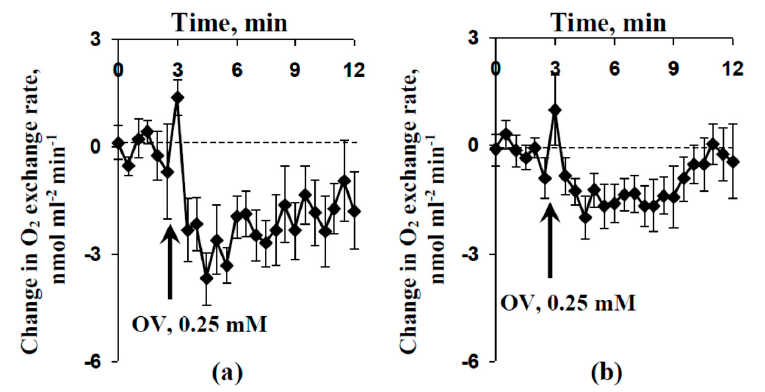
Figure 8. Average changes in O 2 exchange rate induced by injection of sodium orthovanadate (OV) in pea protoplasts under light ( a ) and dark ( b ) conditions ( n = 7–10). OV was dissolved in standard solution (1 mM KCl, 0.5 mM CaCl 2 , and 0.1 mM NaCl); the arrows mark the OV injection into the